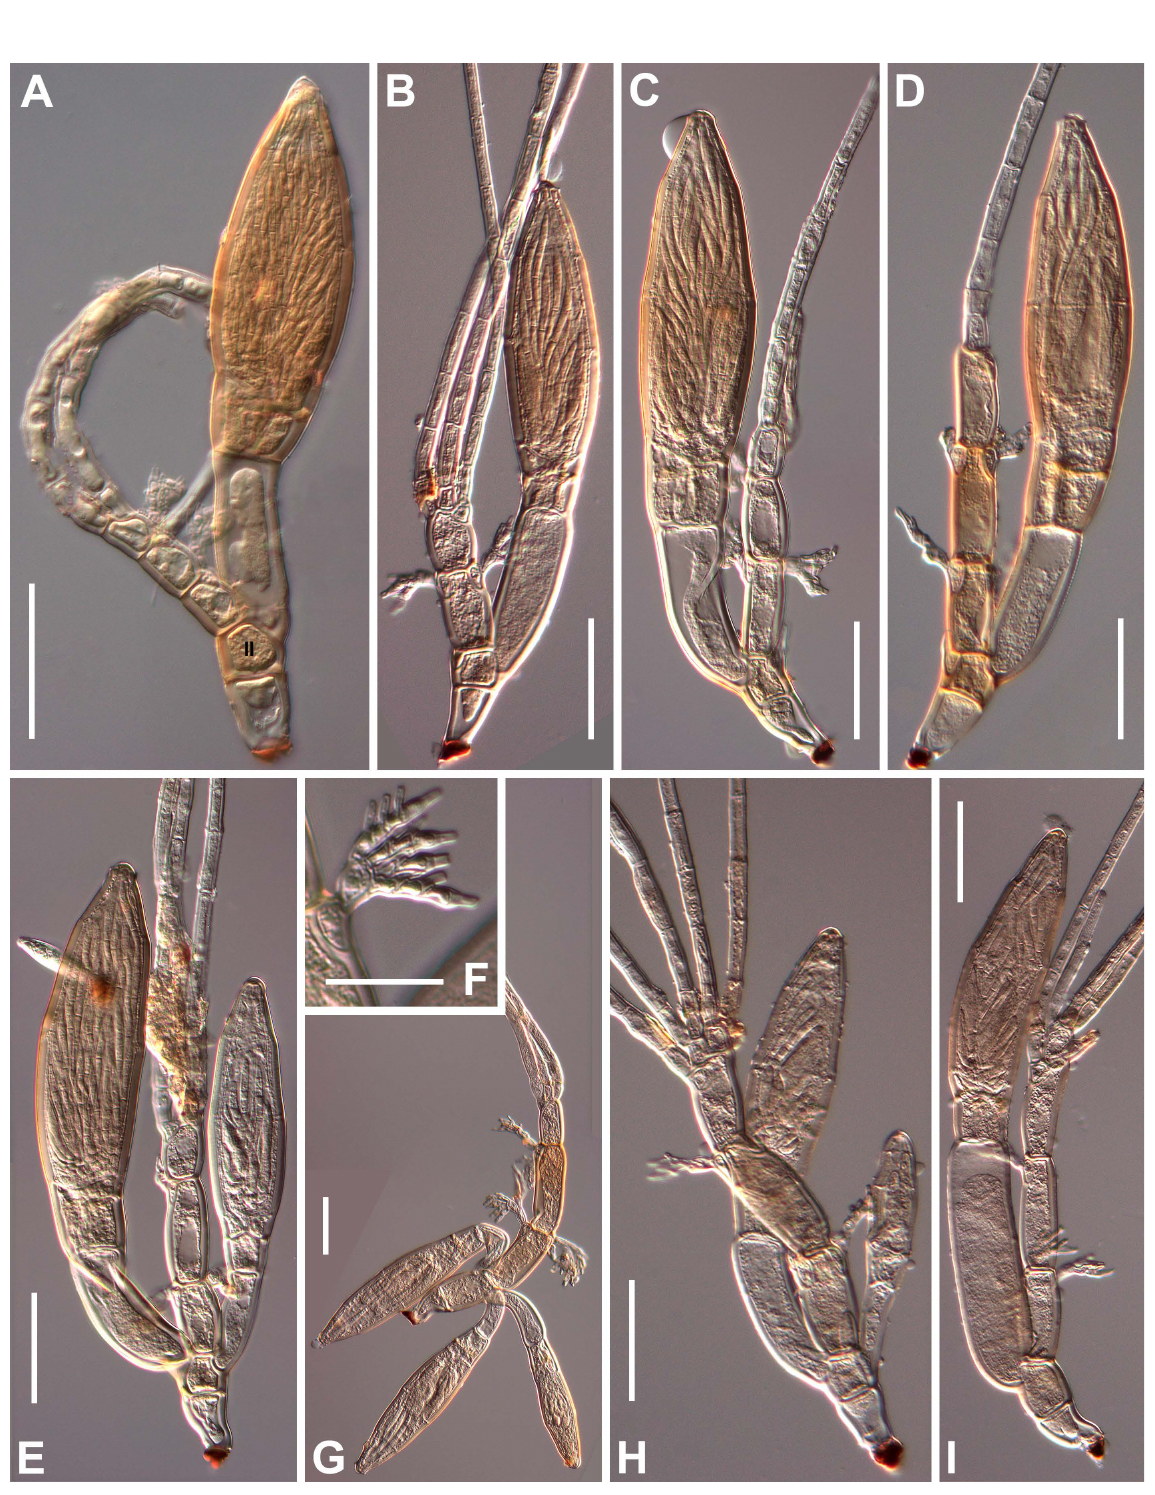
Fig. 54. Rhadinomyces pallidus Thaxt. A . Mature thallus from type slide kept in FH; cell II is labelled. B – E , G – I . Mature thalli showing variability. F . Branch with antheridia in detail. Scale bars: A–E, G–I = 50 µm; F = 25 µm. Photographs from slides FH4591 (A) (type), ZMUC C-F-123008 (B, H–I), ZMUC C-F-122788 (C, E–F), ZMUC C-F-123585 (D), ZMUC C-F-122952